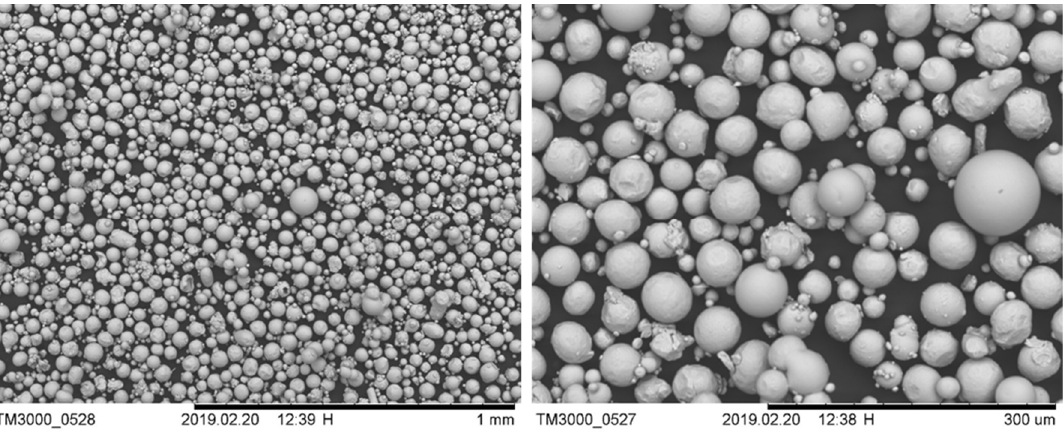
Figure 1. The morphology of the as‐received Ti‐6Al‐4V gas atomised powder.